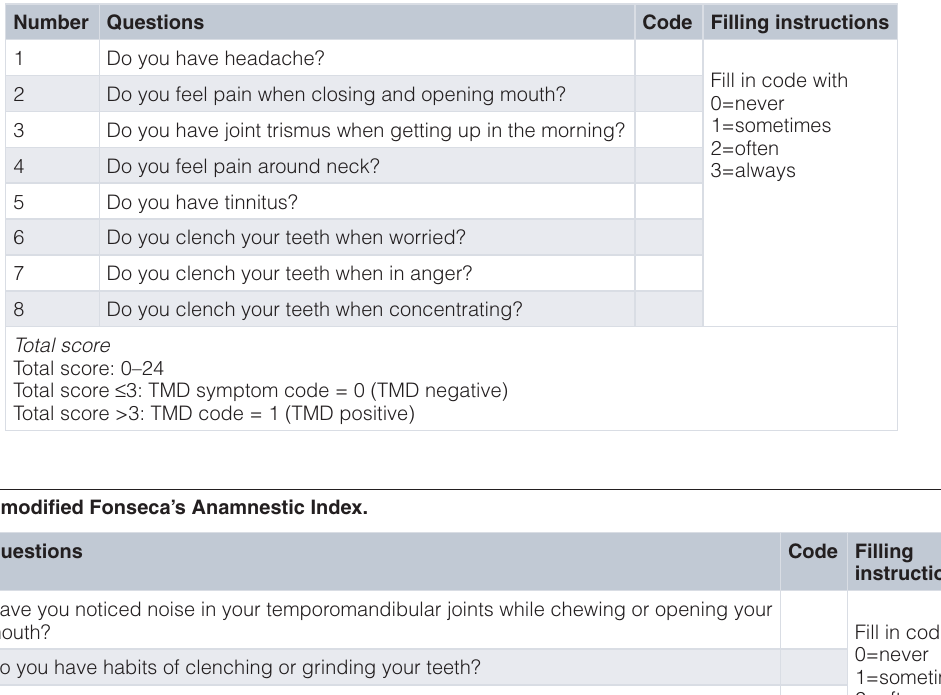
Table 1. Temporomandibular Disorder-Diagnostic Index (TMD-DI).